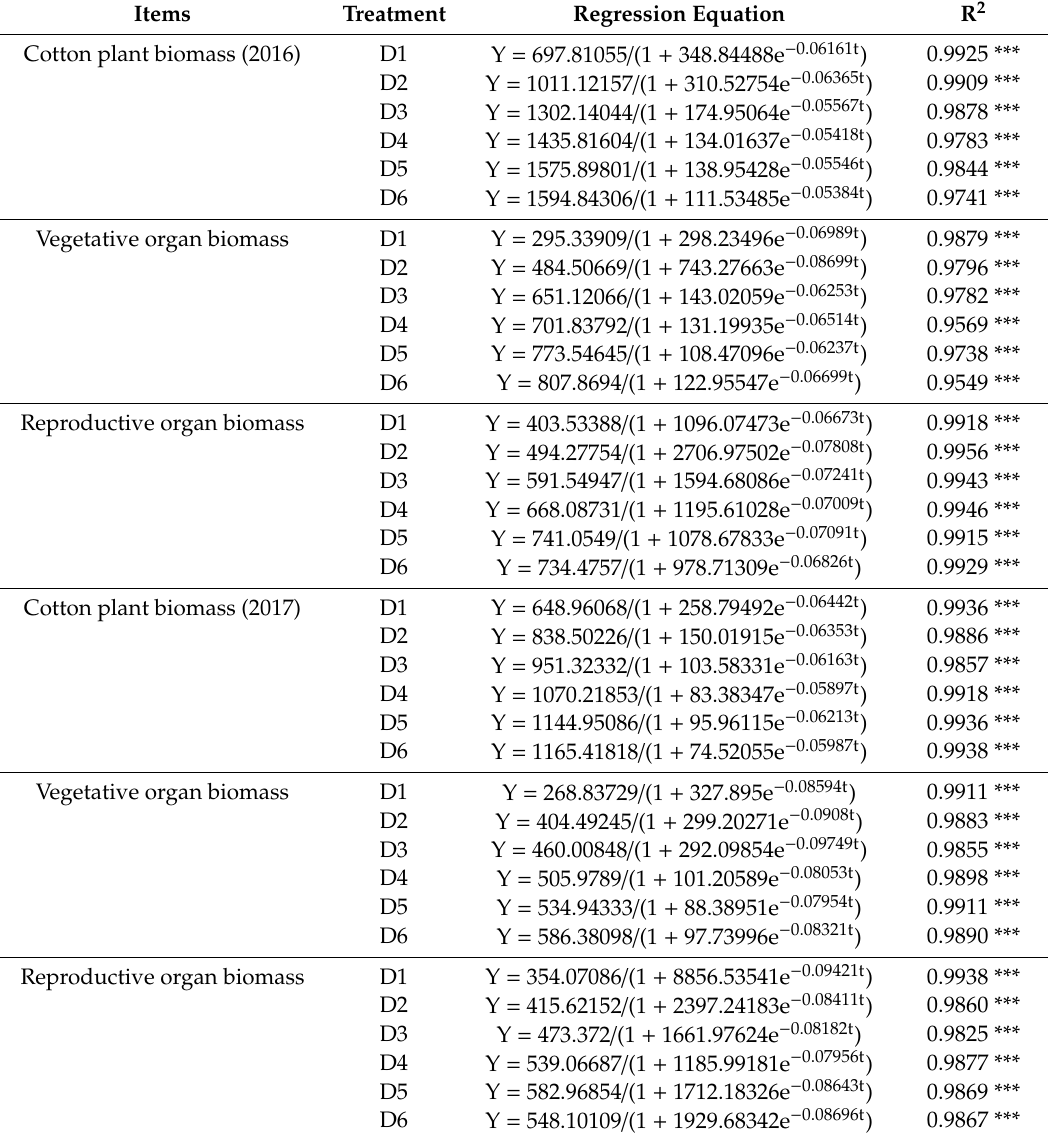
Table 4. Regression of cotton plant biomass accumulation at growing seasons 2016 and